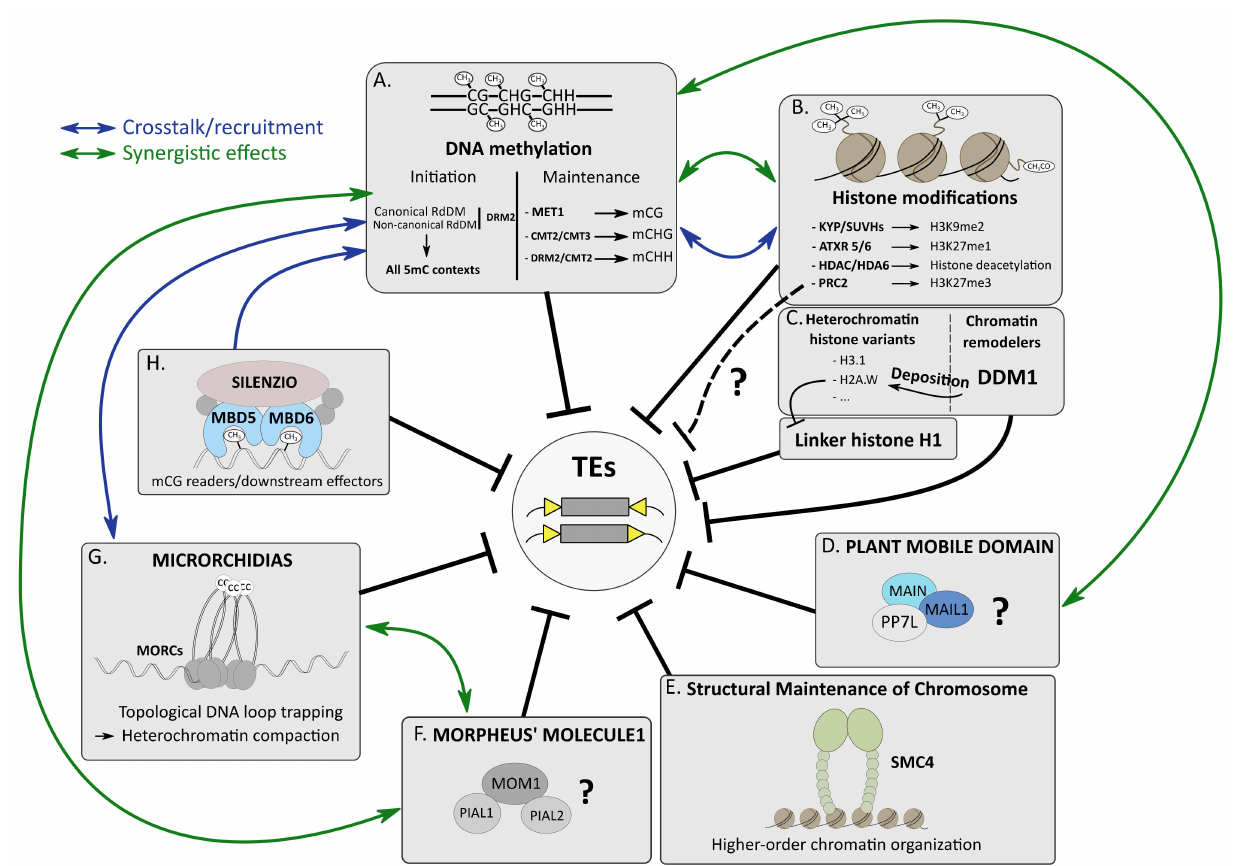
Figure 1. Several silencing pathways cooperate to silence TEs in A. thaliana . ( A ) . Initiation and maintenance of DNA methylation involve specific DNA methyltransferases to perform 5mC in three cytosine contexts. ( B ) . Histone modifications such as methylation of histone 3 at lysine 9 or lysine 27 involve specialized histone methyltransferases. Deacetylation of histone tails requires HDAC proteins, such as HDA6. ( C ) . DDM1 is involved in the deposition of the heterochromatic histone variant H2A.W, which interferes with linker histone H1 occupancy at constitutive heterochromatin. The connections between DDM1, H3K27me3 and 5mC remain unclear. ( D ) . PMD proteins MAIN and MAIL1 interact with PP7L, forming a complex involved in TE silencing through an unknown mechanism. ( E ) . SMC4 cooperates with other epigenetic pathways to repress TEs, presumably by promoting high-order chromatin organization. ( F ) . MOM1 interacts with PIAL proteins to repress TEs using an elusive process. ( G ) . MORC proteins promote constitutive heterochromatin compaction to ensure TE silencing by topological DNA loop trapping mechanism. CC: coiled-coil domain ( H ). The SILENZIO factor interacts with MDB5 and MDB6 and HSP factors to read mCG and silence TEs. Crosstalk and synergistic effects have been described between several epigenetic